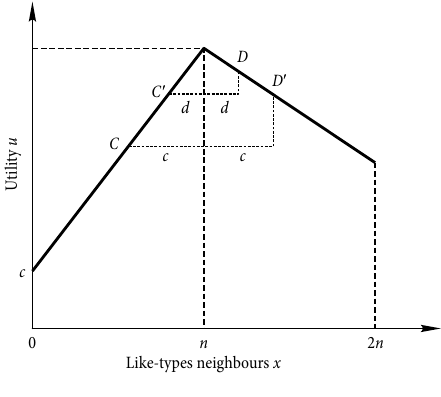
Fig. 5. Interchange of Type